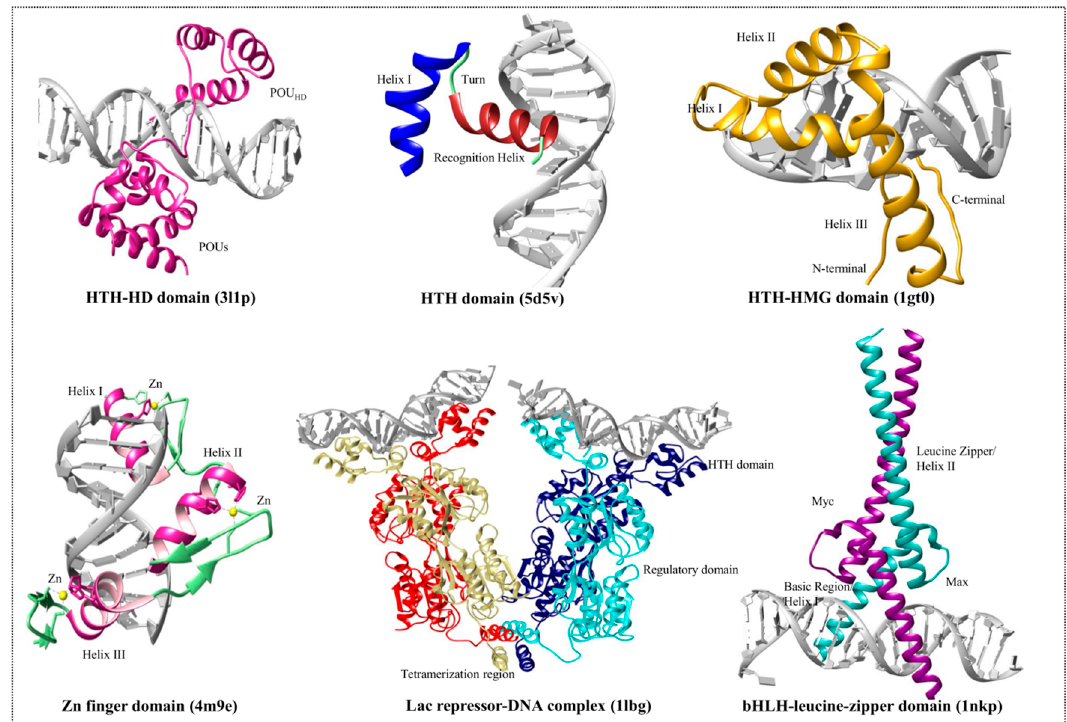
Figure 2. Representative figures of the transcription factor binding domains. The figure shows the crystal structures of different types of TF domains (3l1p, 4m9e, 5d5v, 1lbg, 1gt0, and 1nkp). The structures were obtained from the Protein Data Bank (PDB) and redrawn using chimera. The respective domains and important regions have been labeled. HTH stands for helix-turn-helix domain. bHLH stands for basic helix-loop-helix motif. HD and HMG stand for homeodomain and high-mobility group box domain, respectively.